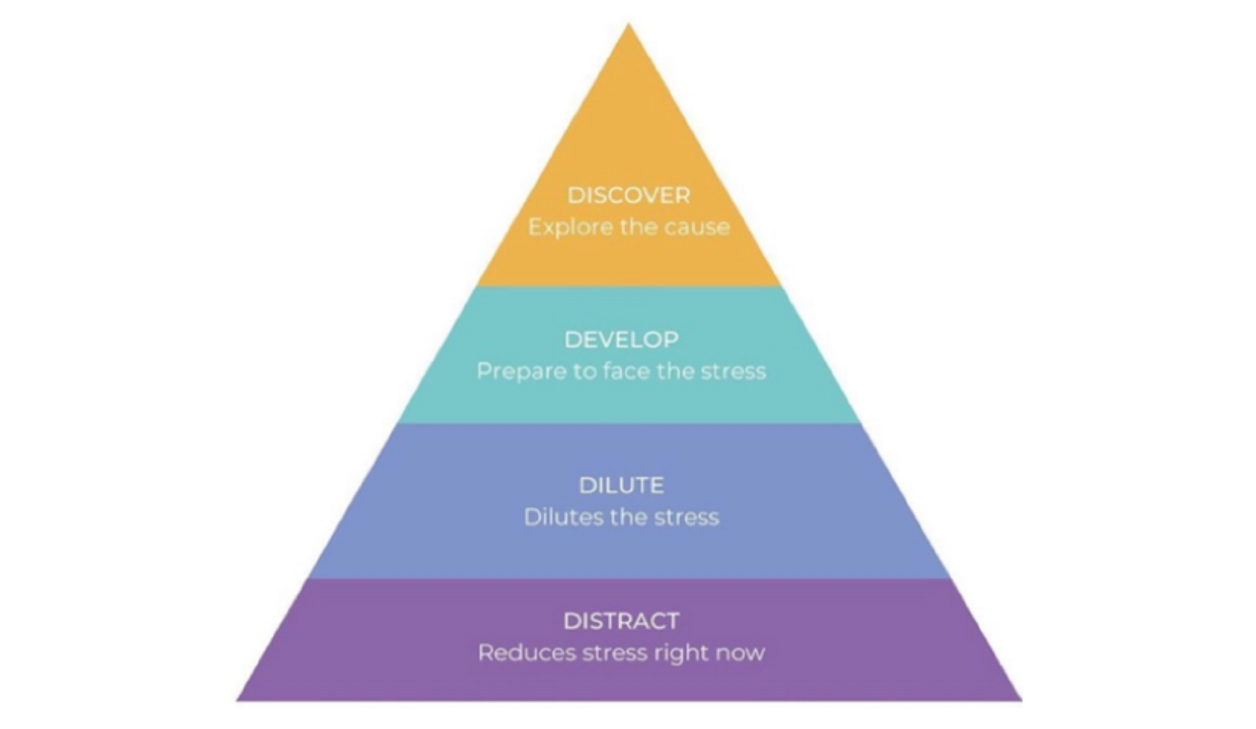
FIGURE 1 | The 4D